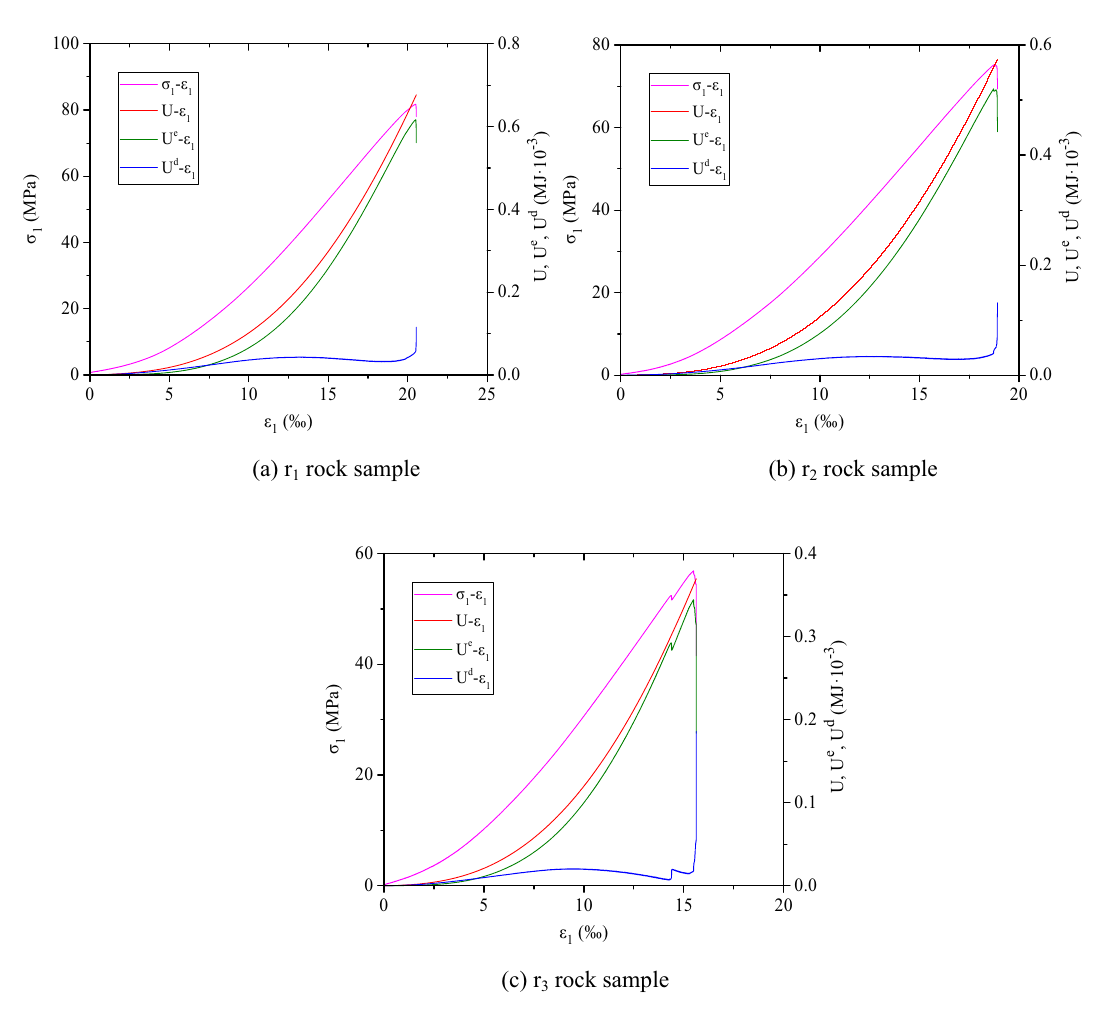
Fig. 7 Complete stress–strain-energy curve of sandstone under uniaxial